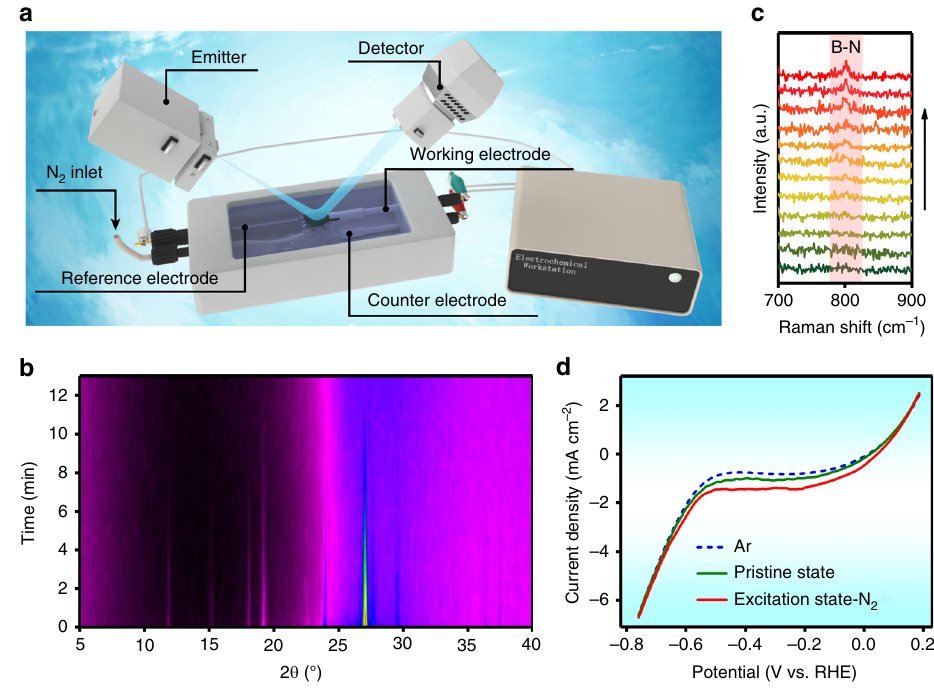
Fig. 3 In situ characterizations and electrochemical responses. a Schematic illustration of the tailor-made electrolytic cell for in situ characterizations. b In situ XRD intensity map, and c in situ Raman spectra of the transformation from COF/NC to Eex-COF/NC. d Linear sweep voltammetry (LSV) curves of different states through